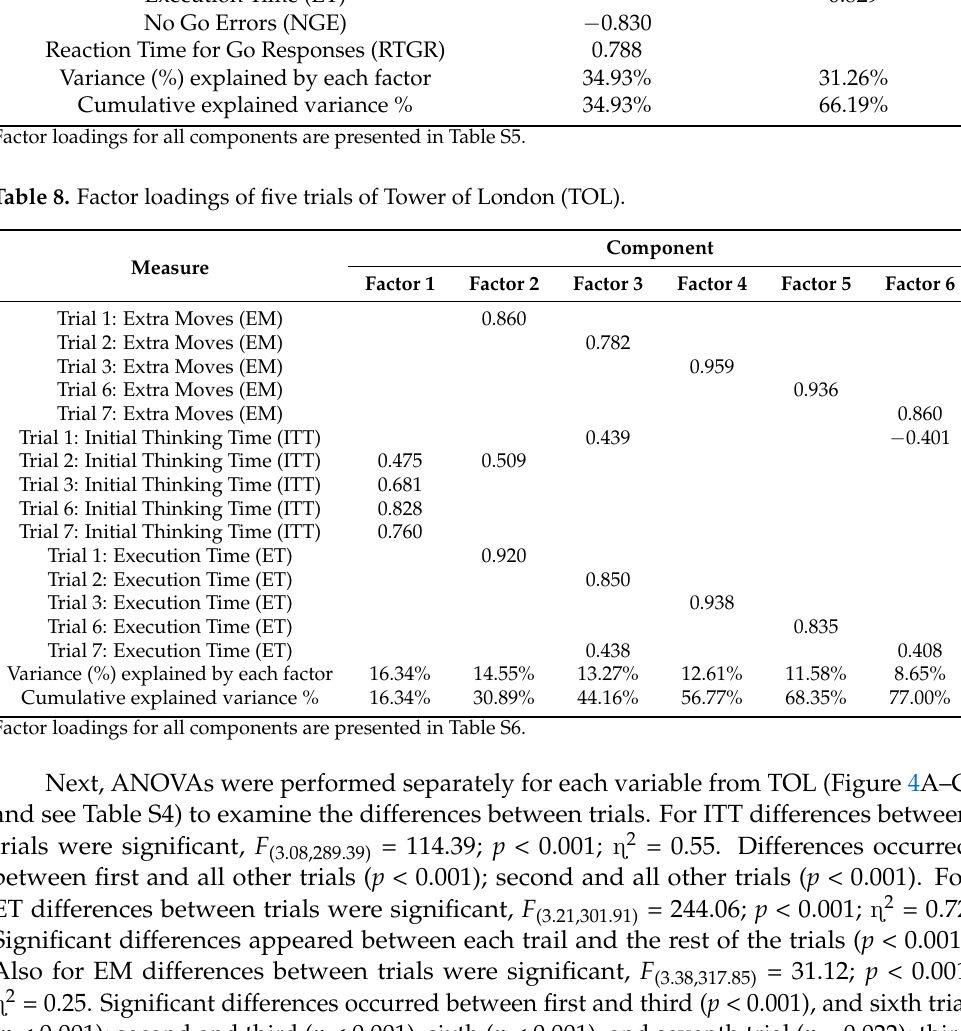
Table 7. Factor loadings of Tower of London (TOL) and Go/No Go (GNG) task. Measure